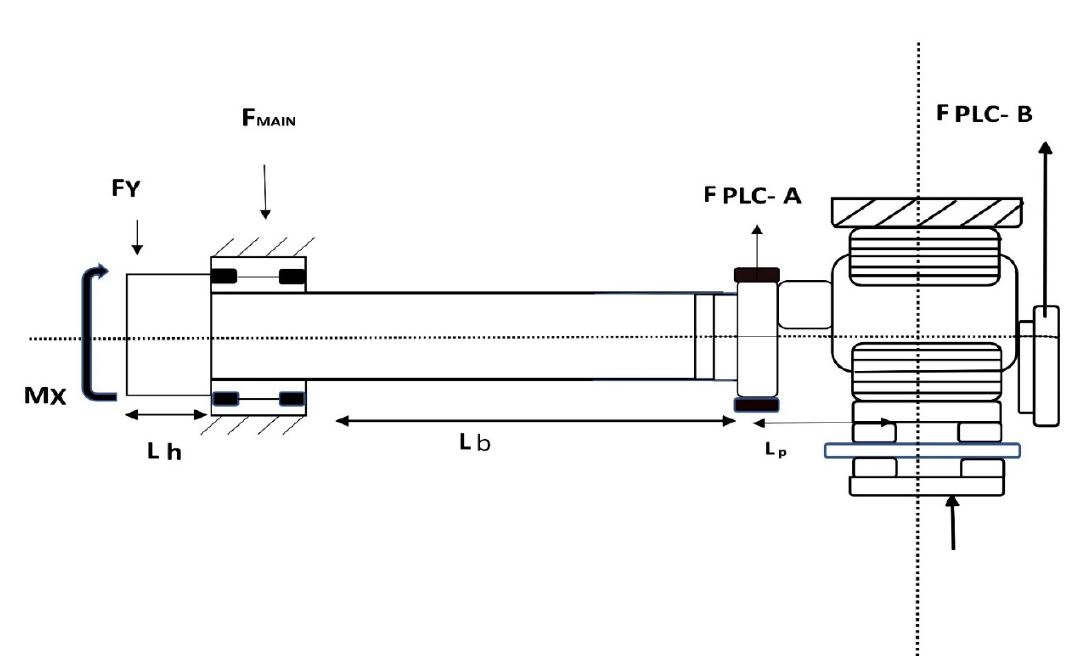
Figure 3. Free body diagram of the system from the hub to the planetary stage own elaboration based on [8,10].